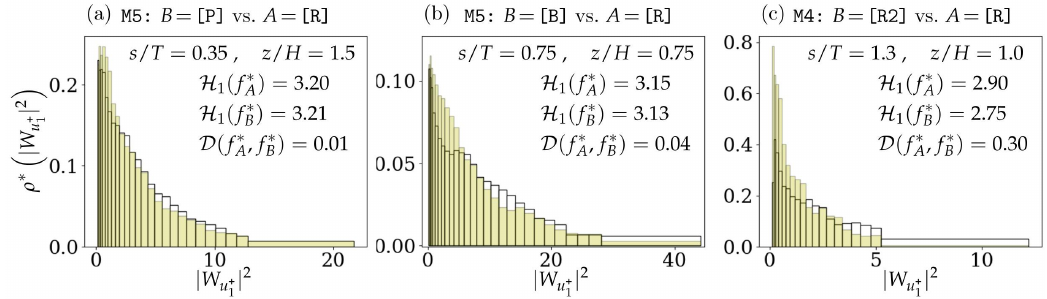
Figure 17. Example discrete sample frequency density distributions ρ ∗ ( • ) = f ∗ ( • ) / ∆ ∗ used to construct the entropy and divergence distributions on ( s , z ) plane as presented in Figure 18: White (colorless) bars are from [R] reference simulation, while the yellow bars are from one of the modified cases. ( a ) Nearly equivalent histograms, both resulting in relatively high entropy values while yielding very low divergence. ( b ) Moderately deviating histrograms which give rise to relatively low divergence. ( c ) Clearly deviating histograms that result in very high divergence. Note the merging of bins at the tail end of the